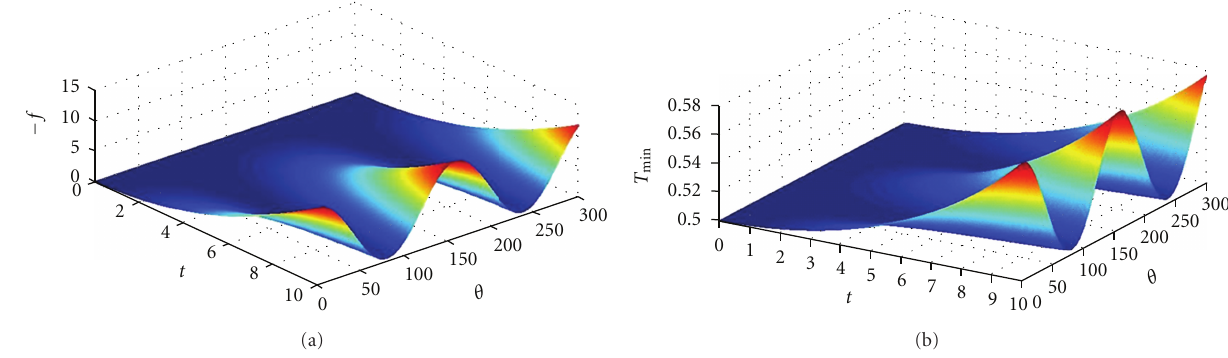
Figure 1: (a) Variation of − f for seven-wave mixing process with respect to interaction time t and initial phase of the coherent state θ . (b) Variation of T min of seven-wave mixing process with respect to interaction time t and initial phase of the coherent state θ .